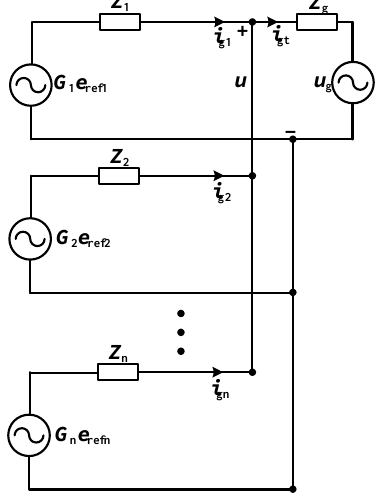
Figure 5. Impedance model of a VSG cluster.